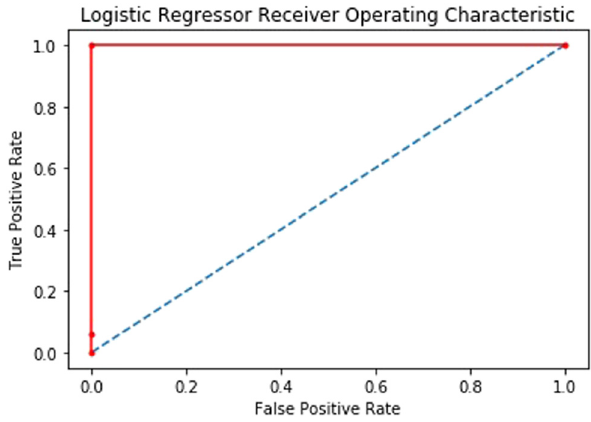
Figure 1: ROC curve of LGR classi fi er performance in distinguishing cancerous and noncancerous prostate